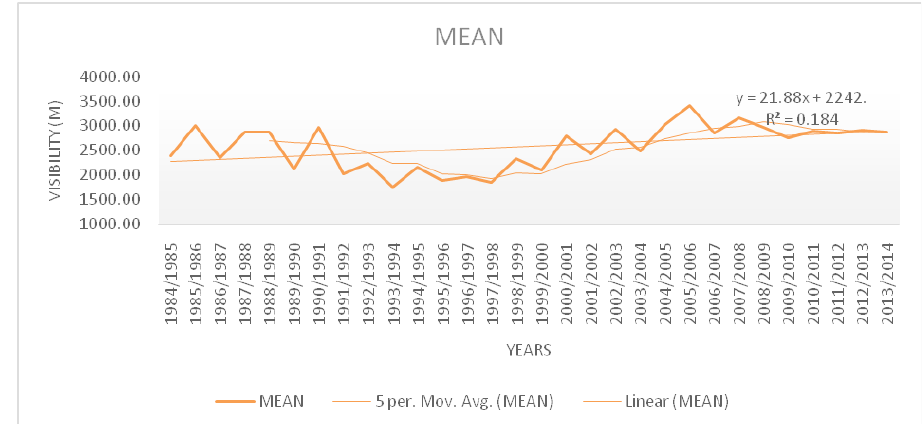
Figure 8: Seasonal mean distributions and trend of air visibility for Yola station